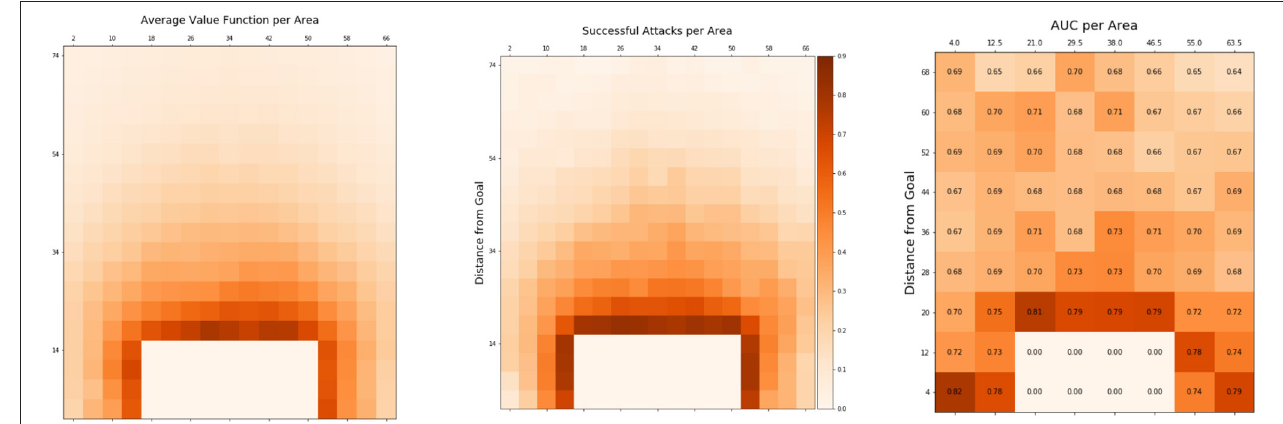
FIGURE 2 | Value function (V) and observed success depending on ball position. Depicted are the distance from the goal line (y-axis) and distance from the sideline (x-axis). (Left) average V per ball position. (Center) true average success rate of attacks after the ball passes through an area. (Right) AUC values comparing V as a predictor for true success.